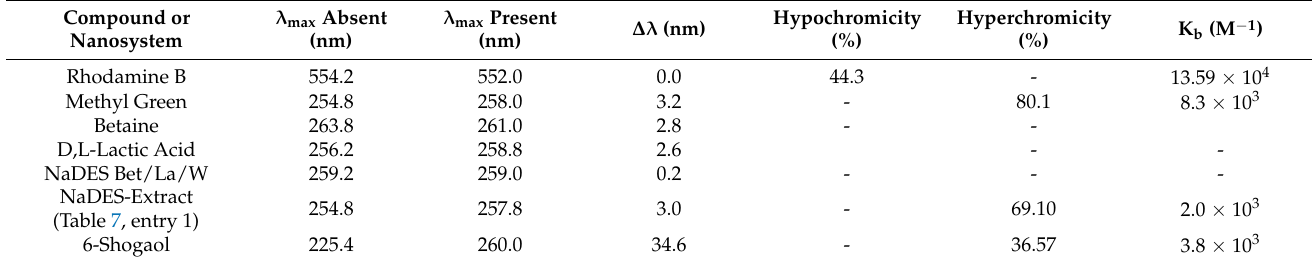
Table 8. UV-Vis absorption data in the absence and presence of